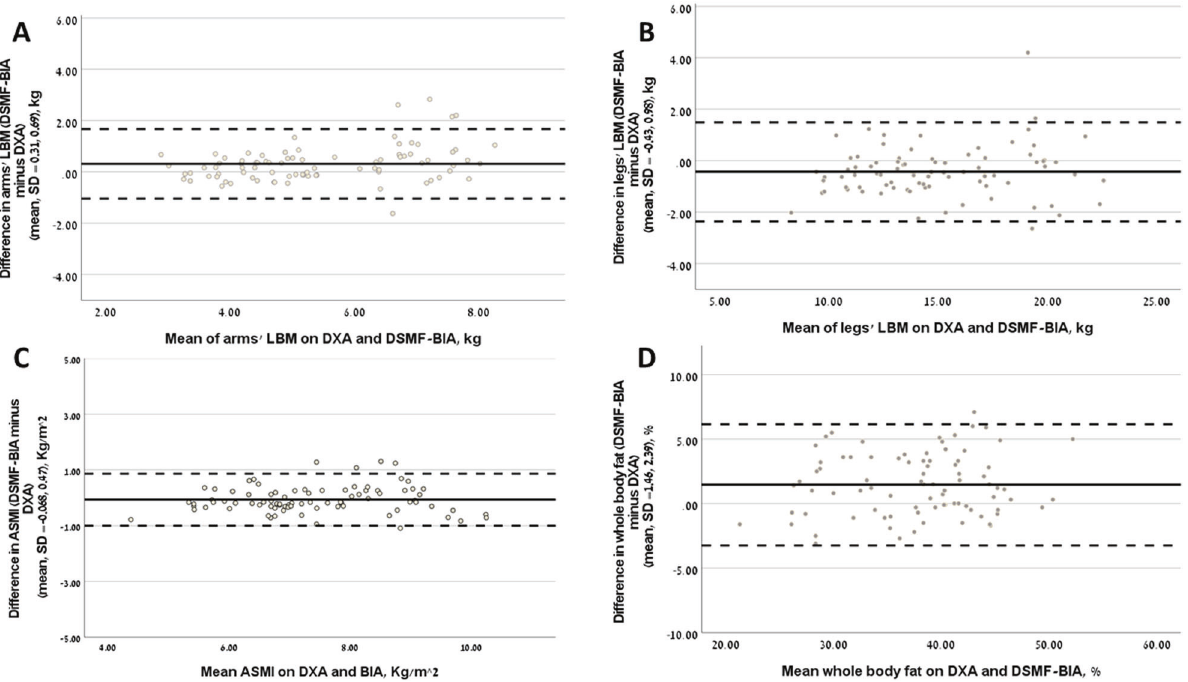
Fig. 2 Bland – Altman analysis of the degree of agreement between DSMF-BIA and DXA. Bland – Altman plots presenting the difference between DSMF-BIA and DXA vs. mean value of A arms lean body mass; B legs lean body mass; C ASMI; D % fat. The solid line represents the mean bias and the broken line the ±1.96 SD. Mean bias is considered the mean difference (of all individuals) between DSMF-BIA and DXA. ASMI appendicular skeletal mass index, DSMF-BIA direct segmental multi-frequency bioelectrical impendence analysis, DXA dual-energy X-ray absorptiometry, LBM lean body mass.